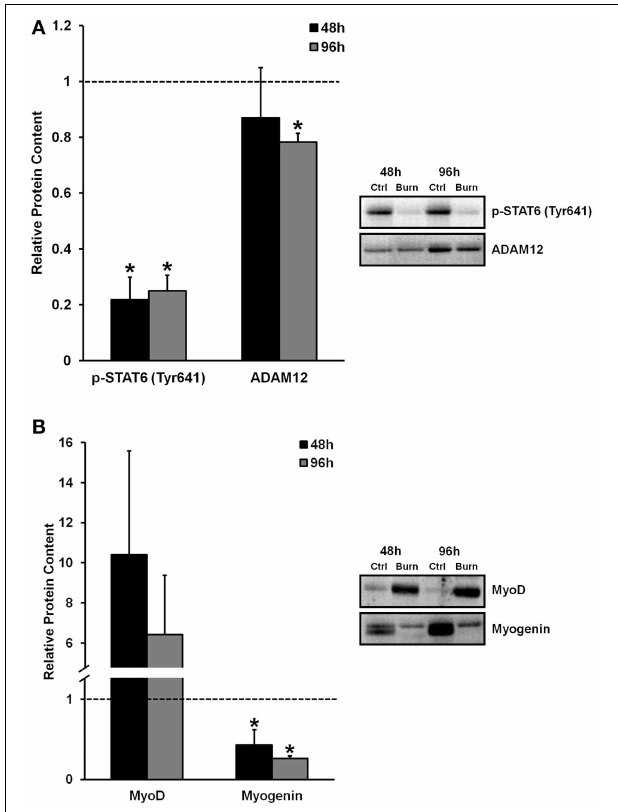
FIGURE 2 | Effects of burn serum on markers of myogenic fusion (A) and myogenic differentiation (B). ∗ Different from control at respective time point; P < 0 . 05 . Dotted line represents control